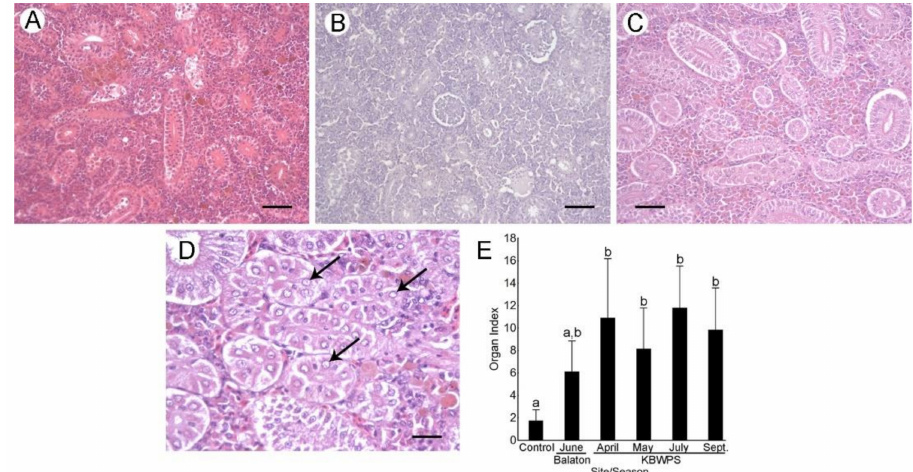
Figure 4. Histopathological alterations of the kidneys of fish caught from Lake Balaton and Kis-Balaton Water Protection System (KBWPS). ( A ) Control individuals demonstrating normal kidney histology. ( B ) Individuals from Lake Balaton showing slight tubular vacuolizations. Individuals from KBWPS displayed severe tubular vacuolizations leading to detachment from the basal membrane ( C ) as well as nuclear alterations, primarily karyolysis ( D ; arrows). H&E staining. Scale bars: ( A – C ): 50 µ m, D : 25 µ m. ( E ) Kidney indices obtained after the semi-quantitative analysis of the histopathological alterations. Different letters above the SD bars indicate statistical significance (Tukey’s HSD, p <